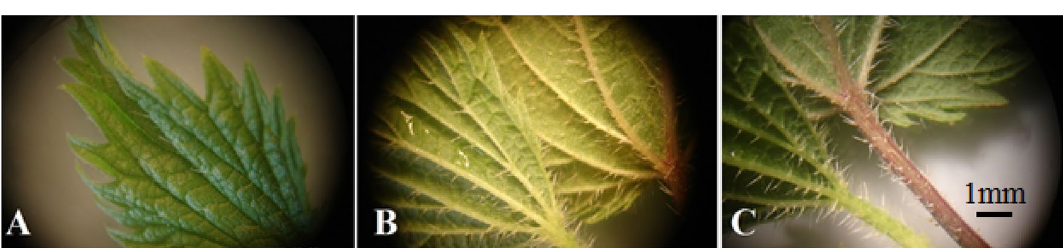
Figure 5. Comparison of stinging hairs frequently on the leaf surface ( A ), behind close-up of leaves ( B ) and nettle leaf tail.